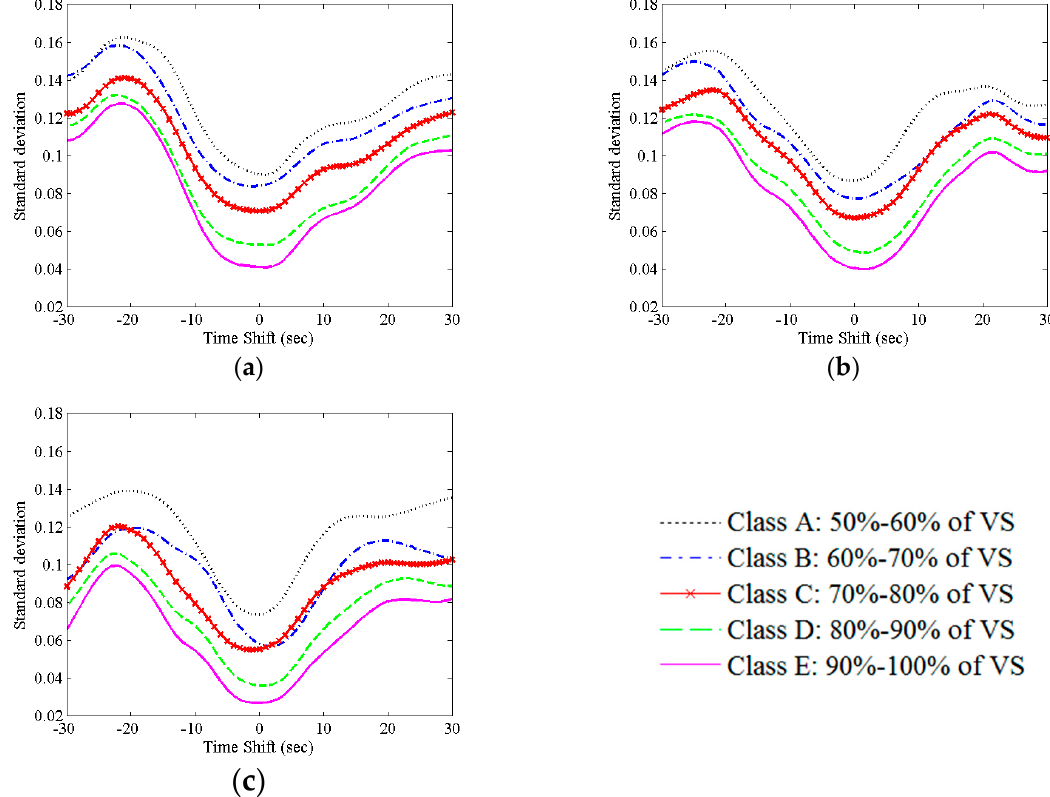
Figure 1. Standard deviation values of cross correlation function in simulated data for different GFPs family (( a ) Maximum CCF = 0.3 ± 0.05; ( b ) Maximum CCF = 0.4 ± 0.05; ( c ) Maximum CCF = 0.5 ± 0.05)